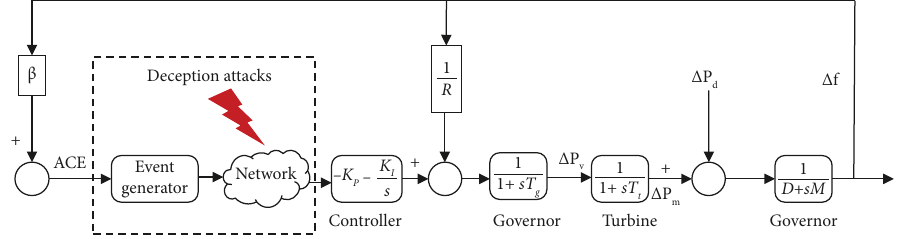
Figure 1: Dynamic mode of the single-area power system under deception attacks. Table 2: Parameters of the power system.